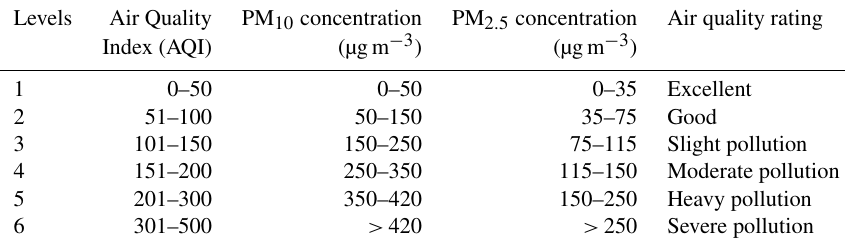
Table 1. Ambient particulate matter concentration related to air pollution levels in